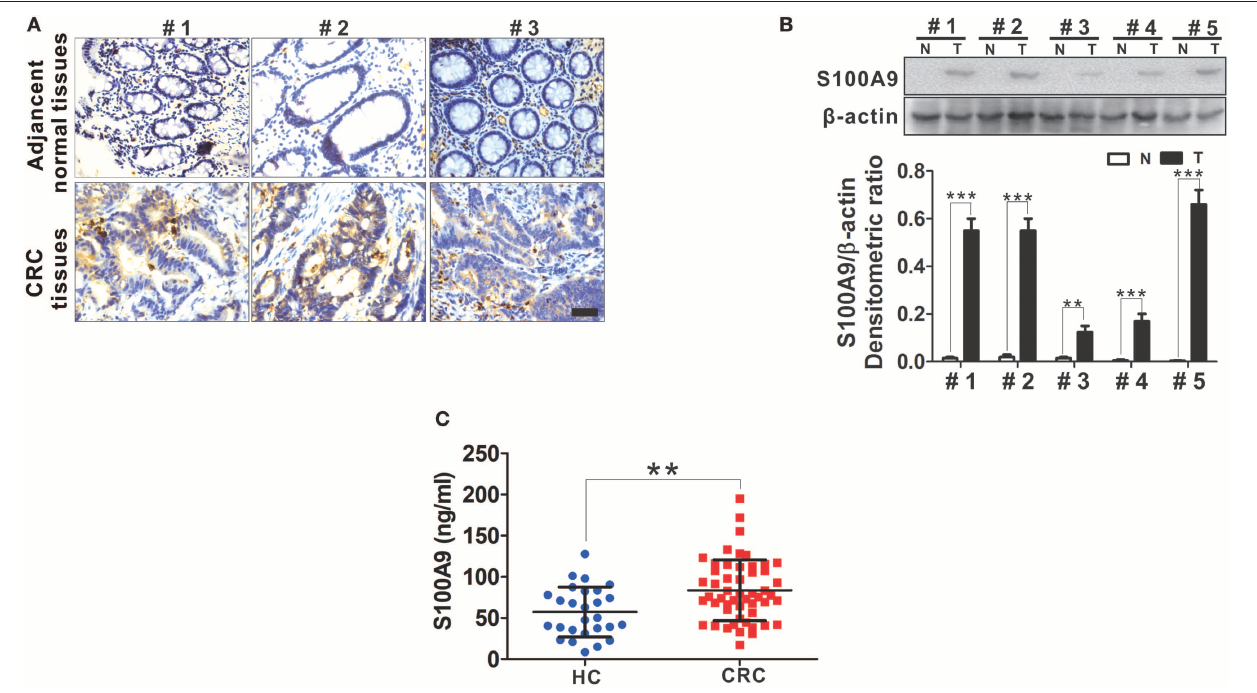
FIGURE 2 | The expression of S100A9 protein in CRC. (A) Representative IHC staining for S100A9 expression in tumor tissues and adjacent normal tissues from three CRC patients. Blank scale bars = 100 µ m. (B) Western blot analysis of S100A9 expression in five randomly selected CRC patients’ tumor tissues and adjacent normal tissues. N, adjacent normal tissues; T, tumor tissues. β -actin served as a loading control. (C) ELISA analysis of serum S100A9 level from HC ( n = 30) and CRC ( n = 52) patients. Data represents the mean ± SD. ** p < 0.01, *** p < 0.001.